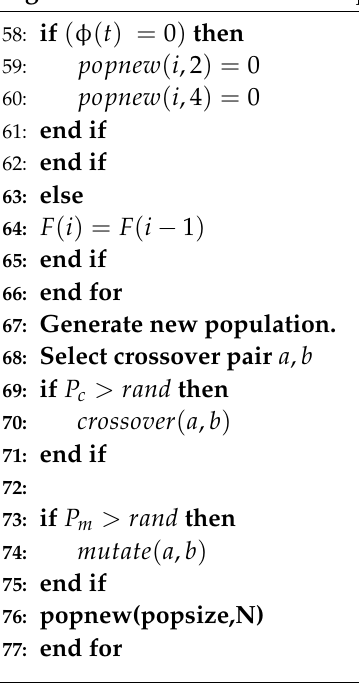
Algorithm 1 Pseudo code of the proposed algorithm for tc and ua appliances.